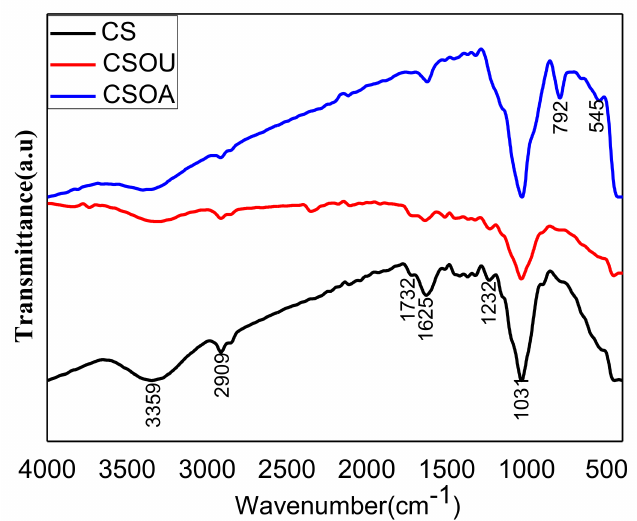
Figure 2. FTIR spectra of CS before and after physico-chemical